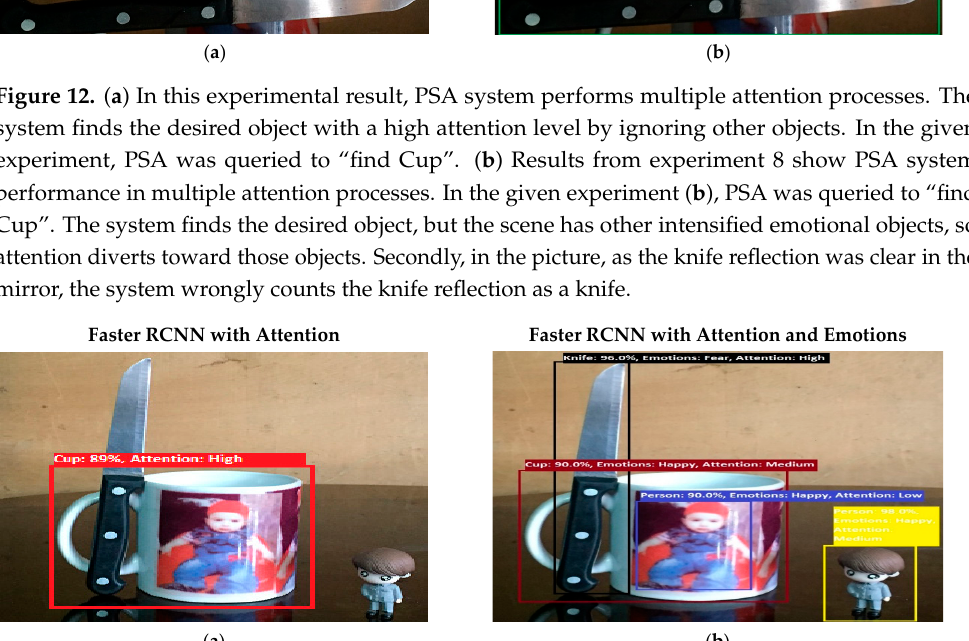
Figure 12. ( a ) In this experimental result, PSA system performs multiple attention processes. The system finds the desired object with a high attention level by ignoring other objects. In the given experiment, PSA was queried to “find Cup”. ( b ) Results from experiment 8 show PSA system performance in multiple attention processes. In the given experiment ( b ), PSA was queried to “find Cup”. The system finds the desired object, but the scene has other intensified emotional objects, so attention diverts toward those objects. Secondly, in the picture, as the knife reflection was clear in the mirror, the system wrongly counts the knife reflection as a knife.